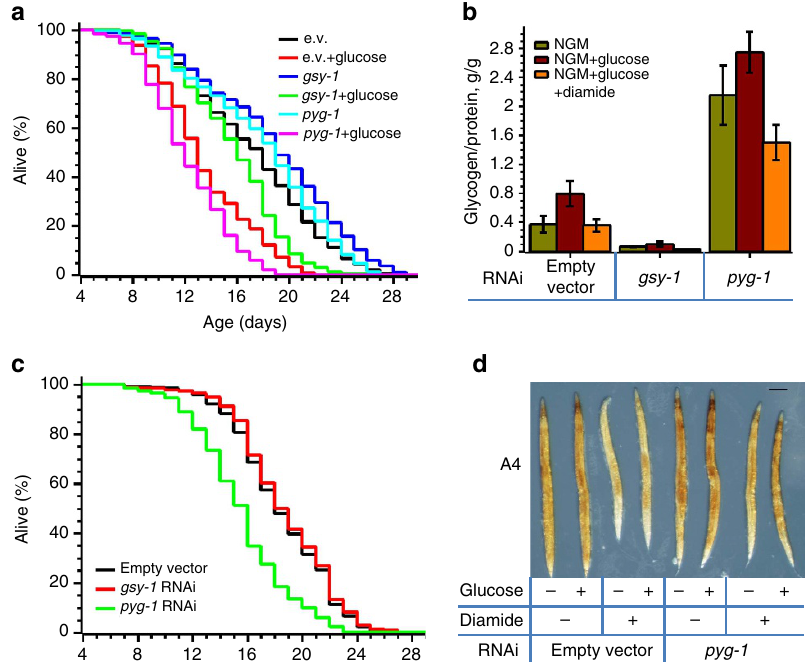
Figure 6 | Glycogen accumulation is responsible for glucose-mediated life shortening. ( a ) Worms lacking glycogen deposition live much longer on a high glucose diet. N2 worms were fed on NGM plates seeded with E. coli HT115 harbouring either empty vector (black and red curves) or plasmids expressing either gsy-1 (blue and green curves) or pyg-1 (cyan and magenta curves) RNAi. L4 stage animals were transferred to NGM plates without (black, blue and cyan curves) or with (red, green and magenta curves) glucose. The graph shows the average of three independent experiments (see also Supplementary Table 2). ( b ) Glycogen content in gsy-1 and pyg-1 knockdown worms. Animals were grown on NGM (green bars), NGM þ 2% glucose (red bars) or NGM þ 2% glucose þ 5mM diamide (orange bars) agar plates as in panel a or c . Seven-day-old worms were then picked, washed and the amount of glycogen determined and normalized to the total protein. The graph shows the average ± s.d. of at least three independent experiments (see also Supplementary Table 3). ( c ) Diamide fails to extend the short lifespan of glycogen phosphorylase-deficient worms fed on high glucose diet. N2 worms were fed on NGM plates seeded with E. coli HT115 harbouring either empty vector (black curve) or plasmid vector expressing either gsy-1 (red curve) or pyg-1 (green curve) RNAi. L4 stage animals were transferred to NGM plates with 2% glucose and 5mM diamide. The graph shows the average of three independent experiments (see also Supplementary Table 2). ( d ) Diamide does not efficiently deplete glycogen in pyg-1 -deficient worms. A representative image of four-day-old worms stained for glycogen with iodine is shown. Scale bar 0.15mm. Experimental conditions were as in panel c .